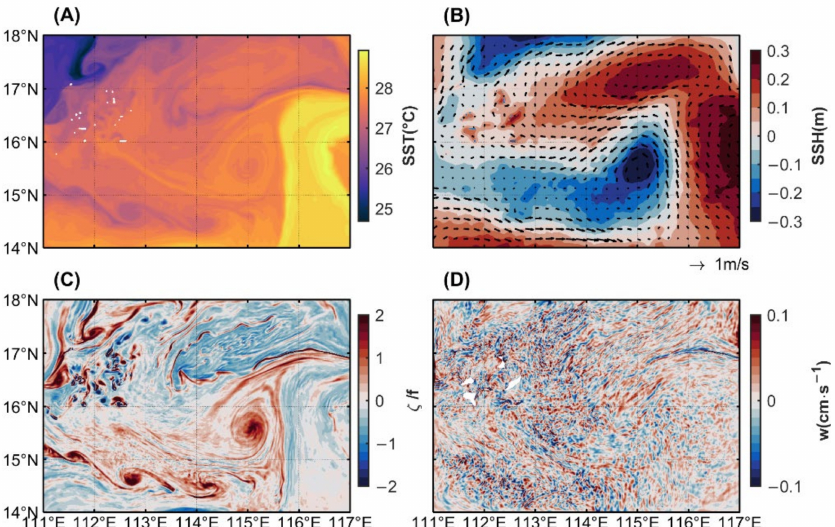
Figure 3. Snapshots of ( A ) sea surface temperature, ( B ) sea surface height and currents, ( C ) relative vorticity normalized by f , and ( D ) vertical velocity at 20 m depth on 4 December 2018. The arrow indicates the horizontal flow